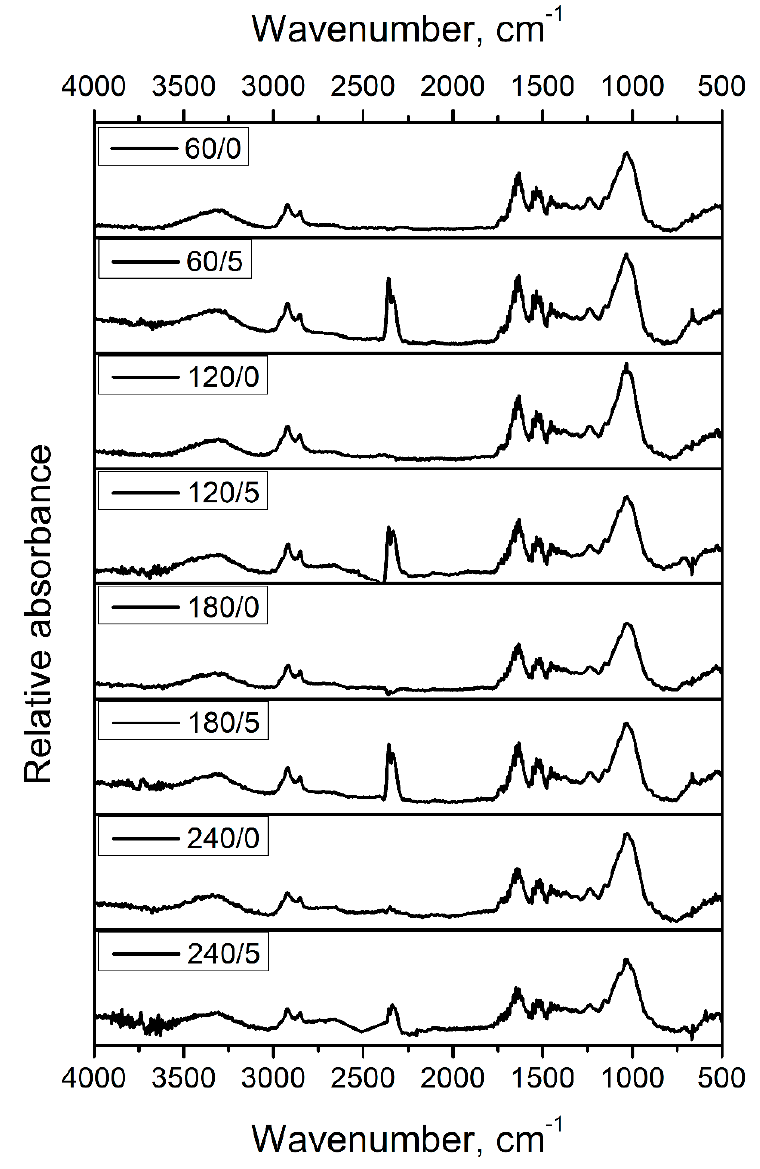
Figure 1. FTIR spectra of different grades of BSG applied as fillers for prepared biocomposites.